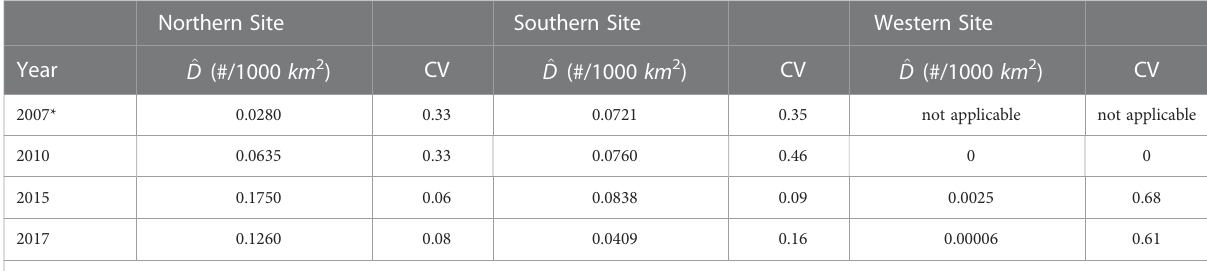
TABLE 6 Estimated average density of Cuvier ’ s beaked whales and associated CV obtained by the bootstrap method.